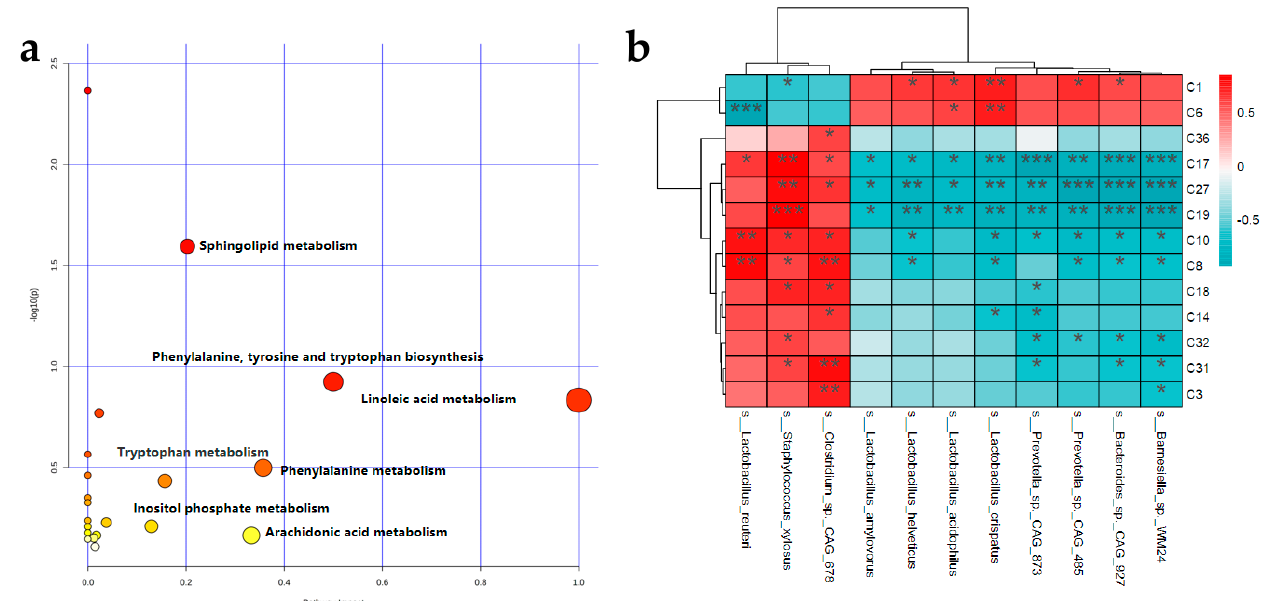
Figure 6. Metabolic pathways and correlation analysis of different metabolites. ( a ) Analysis of metabolic pathways of feces. ( b ) Spearman correlations between differential metabolites and differential bacterial species. Positive correlations indicated by red cubes and negative correlations indicated by blue cubes. * p < 0.05, ** p < 0.01, *** p < 0.001.